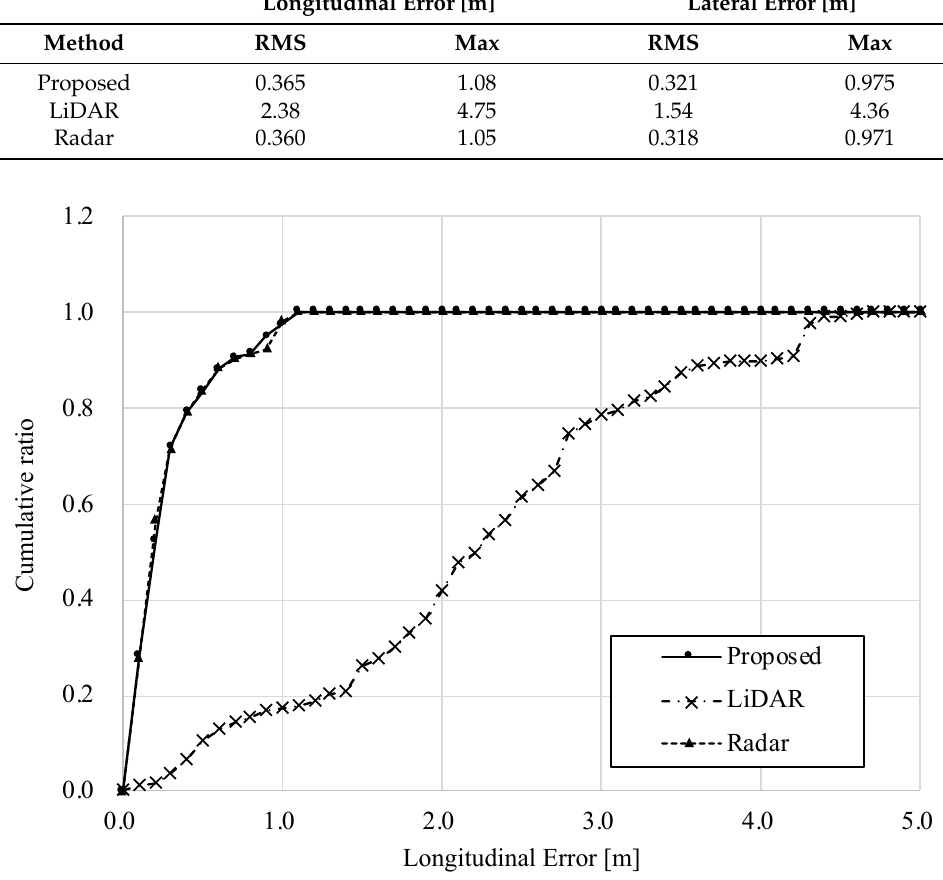
Figure 16. Longitudinal error in snow-covered road surface